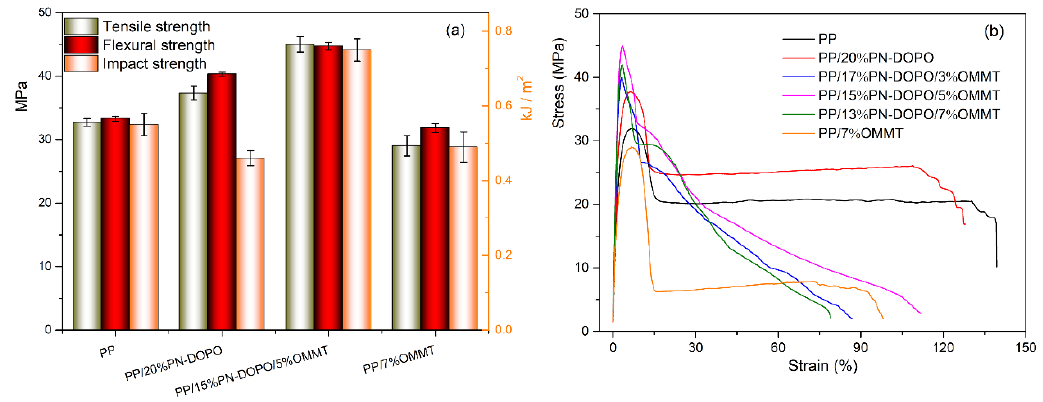
Figure 9. Mechanical properties ( a ) and stress–strain curves ( b ) of PP and flame-retarded PP composites. Table 6. Mechanical properties’ data of PP and flame-retarded PP